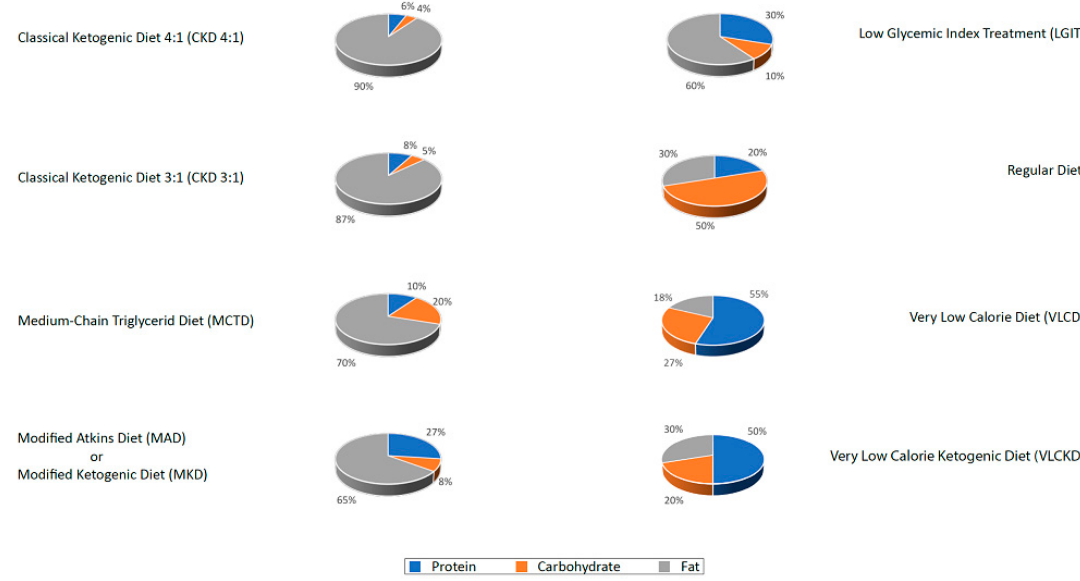
Figure 3. Macronutrient composition of dietary interventions.